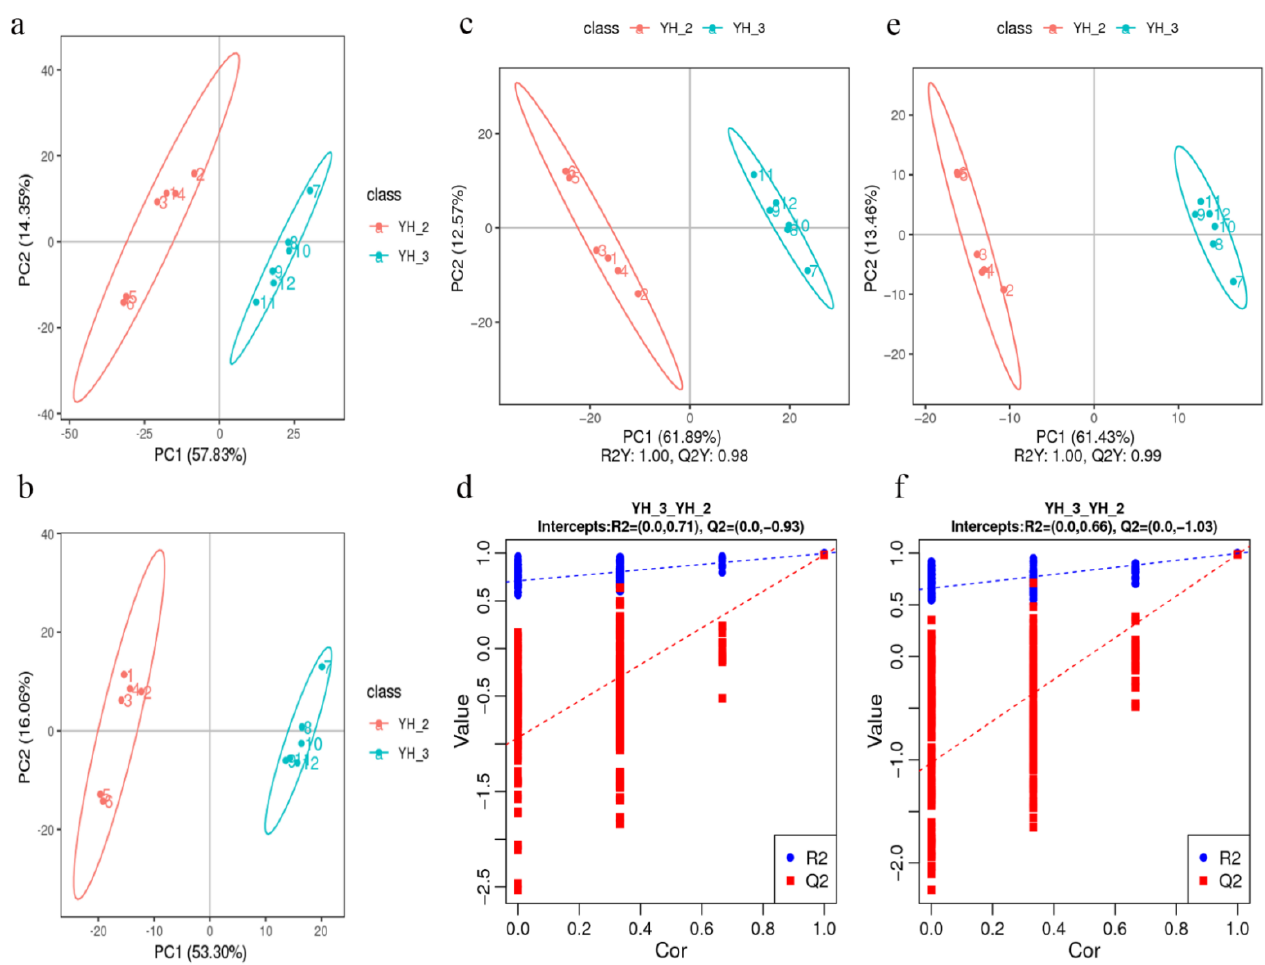
Figure 4. PCA in YH_3 vs. YH_2. ( a ) PCA of the variance-stabilized estimated raw counts of differentially accumulated metabolites in positive polarity mode. ( b ) PCA of the variance-stabilized estimated raw counts of differentially accumulated metabolites in negative polarity mode. ( c ) PLS-DA of differentially accumulated metabolites in positive polarity mode. ( d ) Permutation test for positive polarity mode. ( e ) PLS-DA of differentially accumulated metabolites in negative polarity mode. ( f ) Permutation test for negative polarity mode.